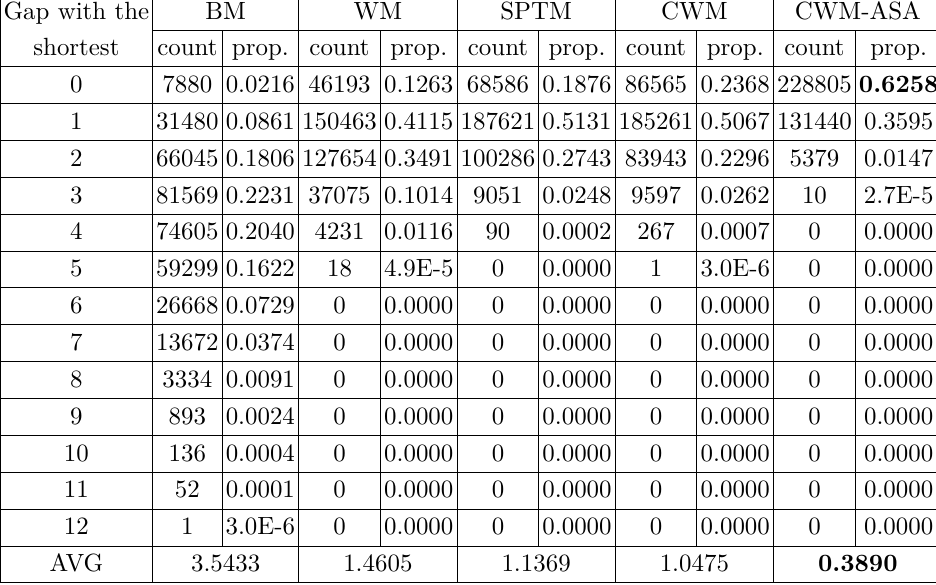
Table 1: Results of all integers with l ≤